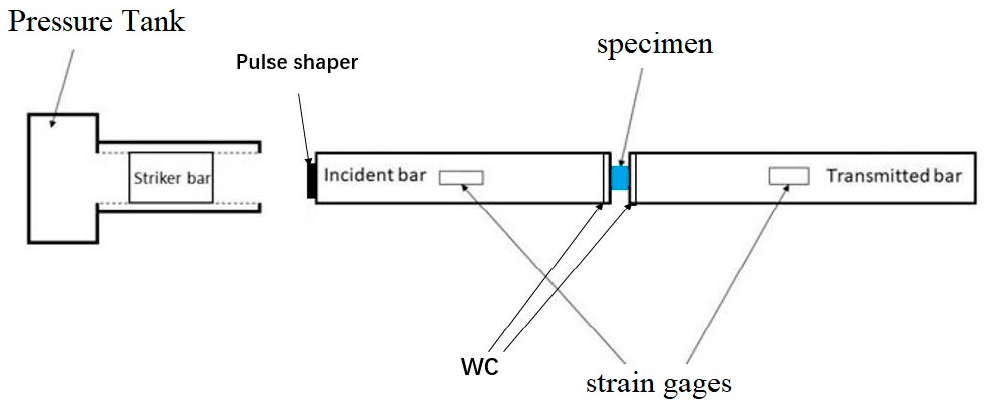
Figure 1. Schematic diagram of the, modified of Split Hopkinson Pressure Bar (SHPB) set up for testing the